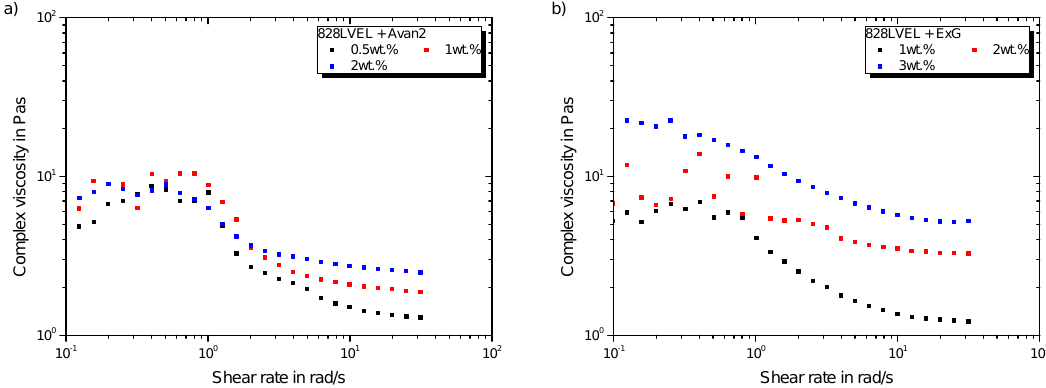
Figure 7. Rheological behavior of Graphene modified 828LVEL and RIMH137/134 ( a ) FLG ( b )